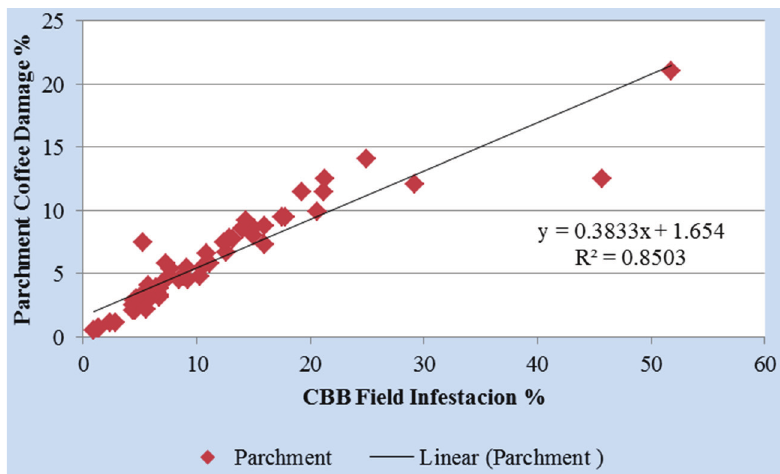
Figure 3. Correlation between CBB infestations levels and damage on parchment coffee. Data from 30 coffee farms in Quindío, Colombia (Source: Aristizábal [84]).